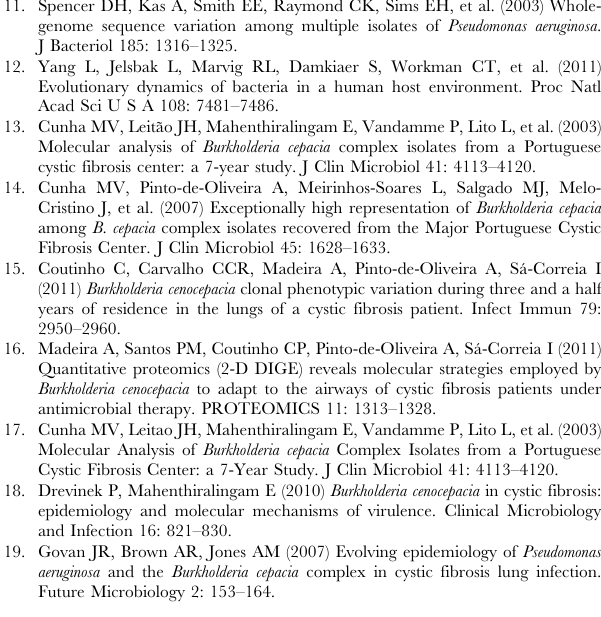
Table S2 Full list of genes up-regulated (above 1.5-fold) in B. cenocepacia IST4113, compared to IST439. The genes whose transcript level in the B. cenocepacia IST4113 variant were at least 1.5-fold higher than the levels attained in the IST439 were selected. The description of gene function is based on the information available in the ‘‘ Burkholderia Genome Database’’ and in ‘‘KEGG Pathways’’ database and the functional clustering was performed using the functional classes shown in Figure 1. Genes specific of the AU1054 strain are shaded in grey. Table S3 Full list of genes down-regulated (above 1.5- fold) in B. cenocepacia IST4113, compared to IST439. The genes whose transcript level in the B. cenocepacia IST4113 variant were at least 1.5-fold lower than the levels attained in